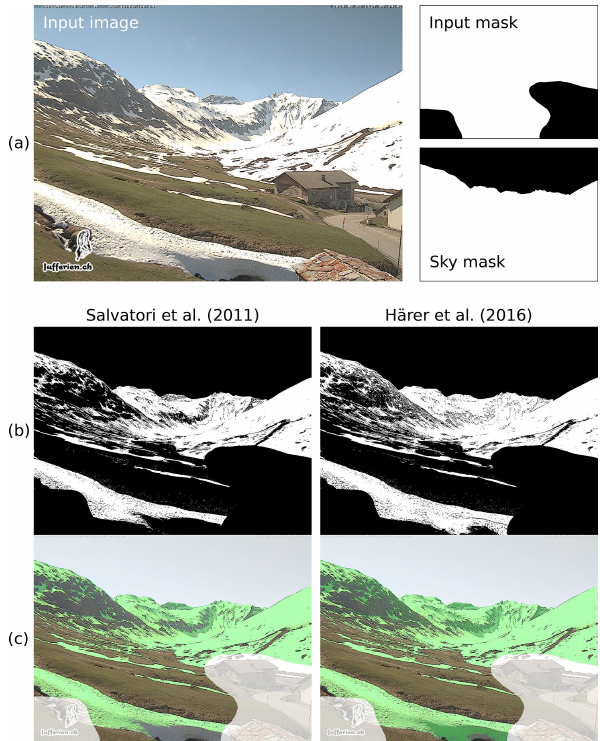
Figure 10. Example of a webcam image that is masked for sub- sequent snow classification using an input mask and a sky mask derived from the extracted mountain silhouette (a) . Snow classifi- cation is applied using the methods by Salvatori et al. (2011) and Härer et al. (2016). Detected snow is shown (b) in white in the bi- nary output image (black: no snow or masked out) and (c) as a trans- parent green layer on the original webcam image (white transparent layer: masked region). Webcam image: Juf, ©